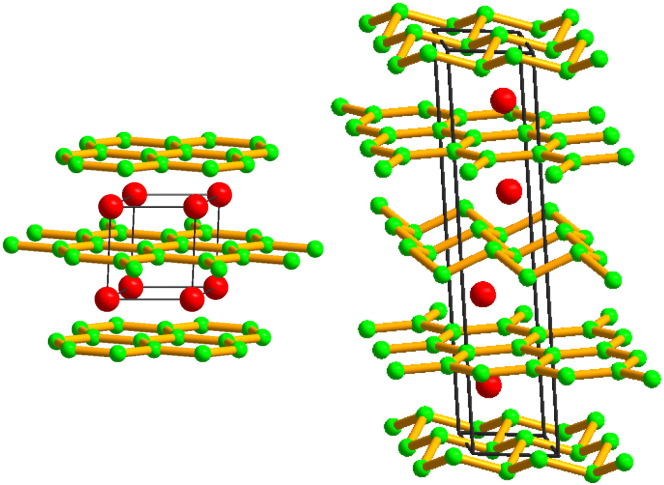
Layer structure of AlB2 (left) and WB2 (right) prototypes.